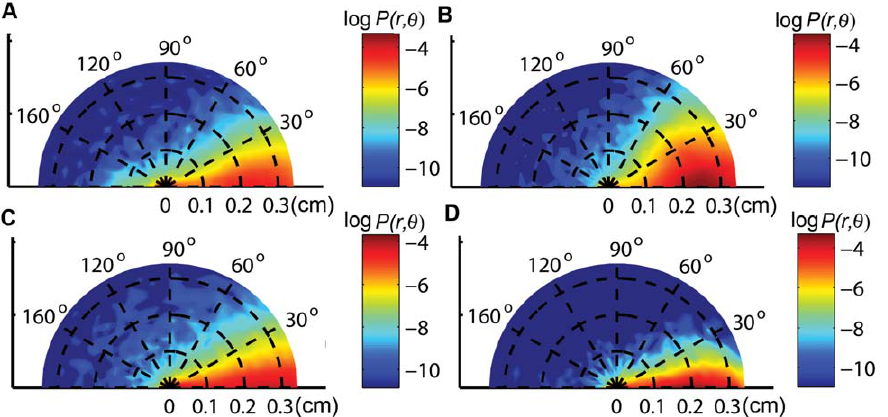
Figure 9. Directional persistence probability P ( r , h ) for four mutant flies. P ( r , h ) for w 1118 , norpA 7 , gprk1 KO 9 a and rut 2080 mutants are shown in panels A , B , C and D , respectively. The densities are shown in logarithmic scale. From the density plots, we found that 54.95%, 81.92%, 72.92%, 70.77% of the movements were restricted to an absolute turn angle of 30 o in w 1118 , norpA 7 , rut 2080 , and gprk 1 KO 9 a , respectively. This shows that these mutants display different degrees of directional persistence in the central zone.